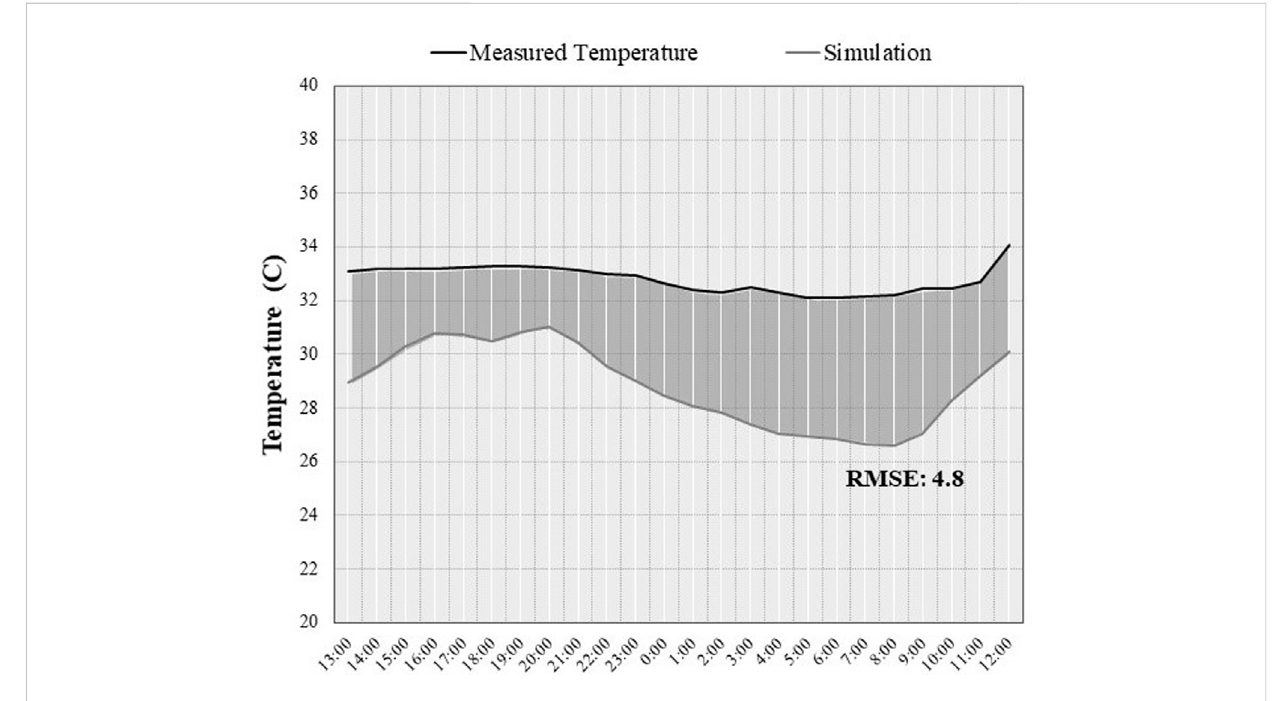
FIGURE 6 Simulation results for indoor air temperature and recorded summer measurements.